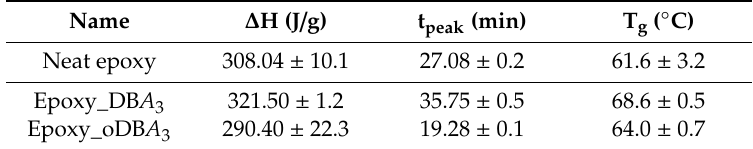
Figure 4. Isothermal DSC scans at 50 ◦ C of the EC01–IPDA epoxy resin. The lowest curve (black) corresponds to the neat epoxy resin. The other curves correspond to the epoxy resin filled with 3 wt.% DBA (red) and oDBA (blue curve). Table 5. Enthalpy, normalized with respect to the resin weight ( ∆ H ) and peak time ( t peak ) obtained by isothermal DSC scans at 50 ◦ C, for the neat epoxy resin and the epoxy resin with DBA or oDBA.